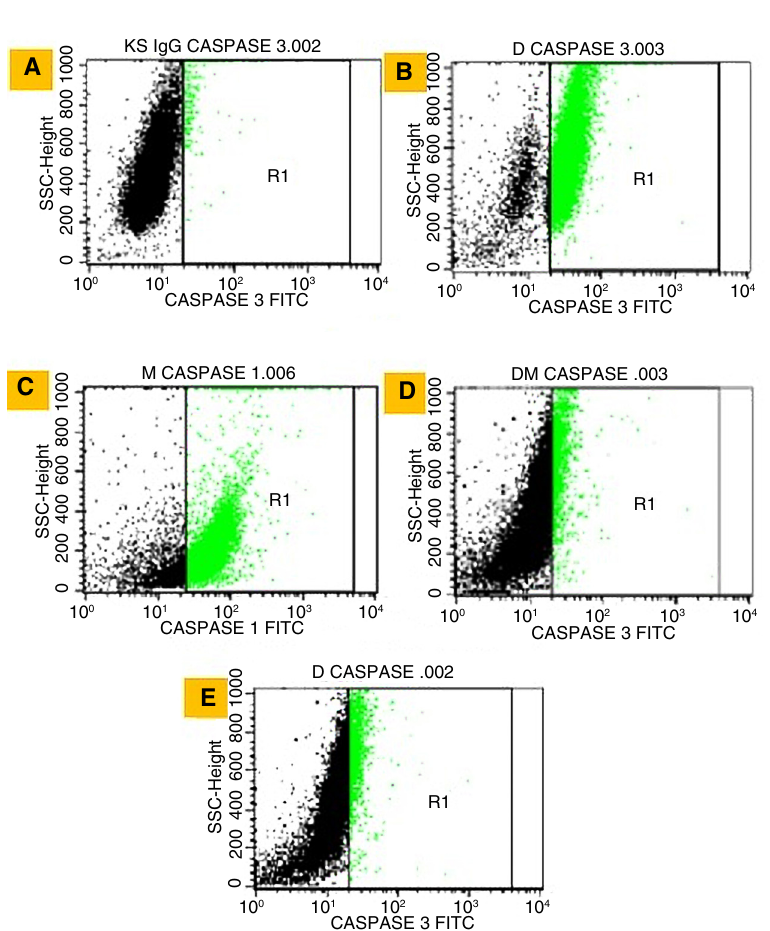
Figure 4. Detection of caspase-3 activation in breast cancer T47D cells after treatment with extracts of Ancorina sp. Negative control ( A ), Doxorubicin ( B ), Methanol ( C ), Dichloromethane:Methanol ( D ) and Dichloromethane ( E ). Black area indicated control cells while R1 showed caspase-3 activated